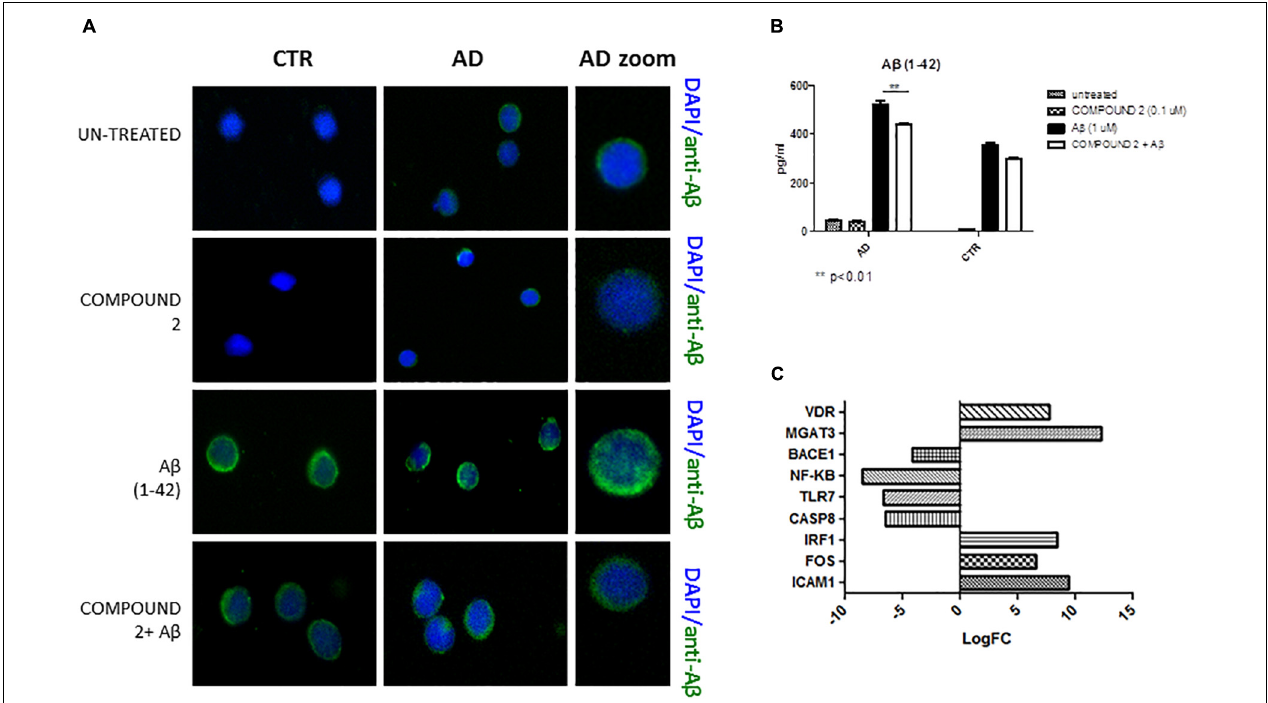
FIGURE 7 | Peripheral blood mononuclear cells from AD patients and control subjects treated with A β (48 h) and untreated, COMPOUND 2 (24 h) and COMPOUND 2 (24 h) + A β (24 h). (A) Immunohistochemistry images; (B) A β Alpha Technology Assays; (C) Deregulated RNAs between PBMCs treated with A β and treated with COMPOUND 2 + A β